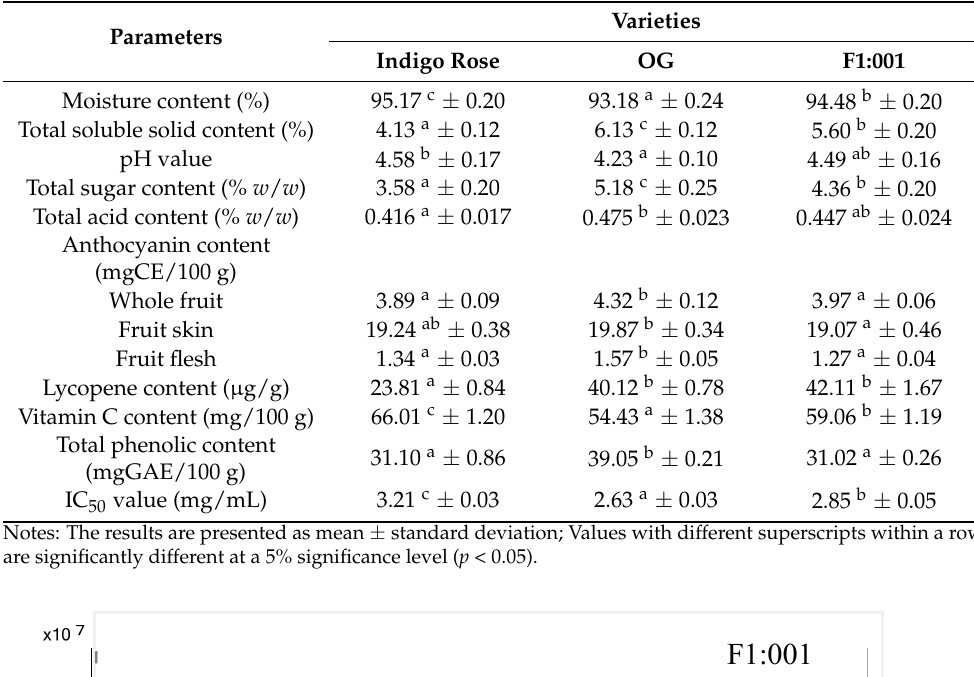
Figure 3. Mass spectra of [M+H]+ ions in three varieties of black cherry tomatoes.